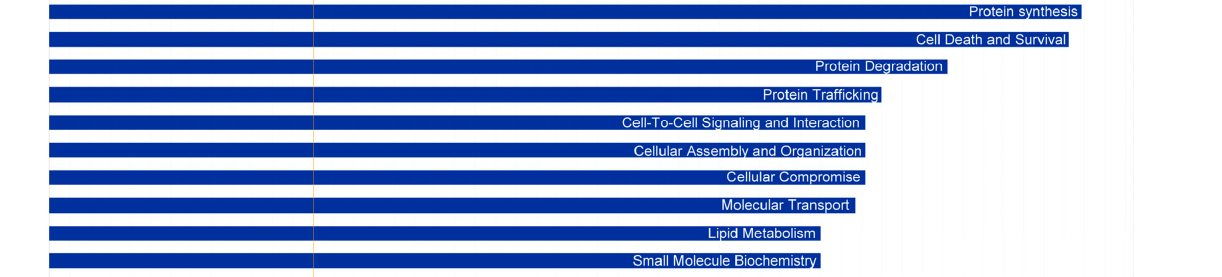
Figure 1. A functional analysis of the differentially expressed proteins with Ingenuity Pathway Analysis in sSS ‐ DED patients versus pSS ‐ DED patients indicated its top association with protein synthesis.